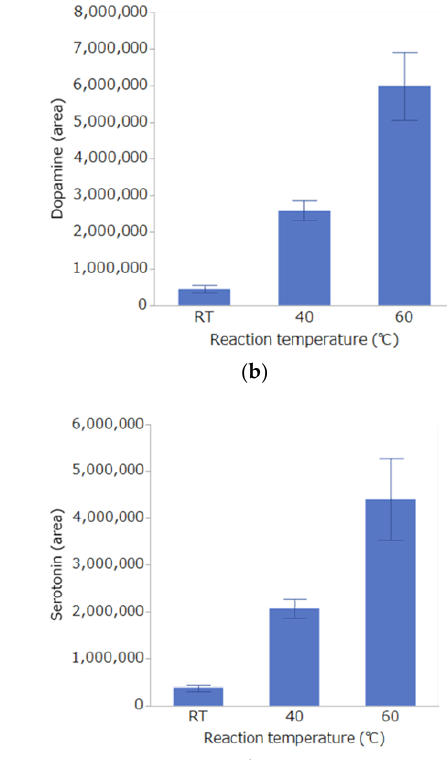
Figure 3. Effect of reaction time on derivatization with DPP. Detection of 3-MT ( a ), dopamine ( b ), histamine ( c ), and serotonin ( d ) by LC-MS/MS. Bar graphs indicate the mean ± SE of each condition ( n = 5 per condition). Different characters indicate significant differences, while identical characters indicate non-significant differences, as determined by Tukey-HSD tests. The results of the reaction temperature study are shown in Figure 4. The concentra- tion increased in a temperature-dependent manner, and the reaction efficiency was max- imal at 60 °C for all of the substances. Therefore, the reaction temperature was set to 60 °C.